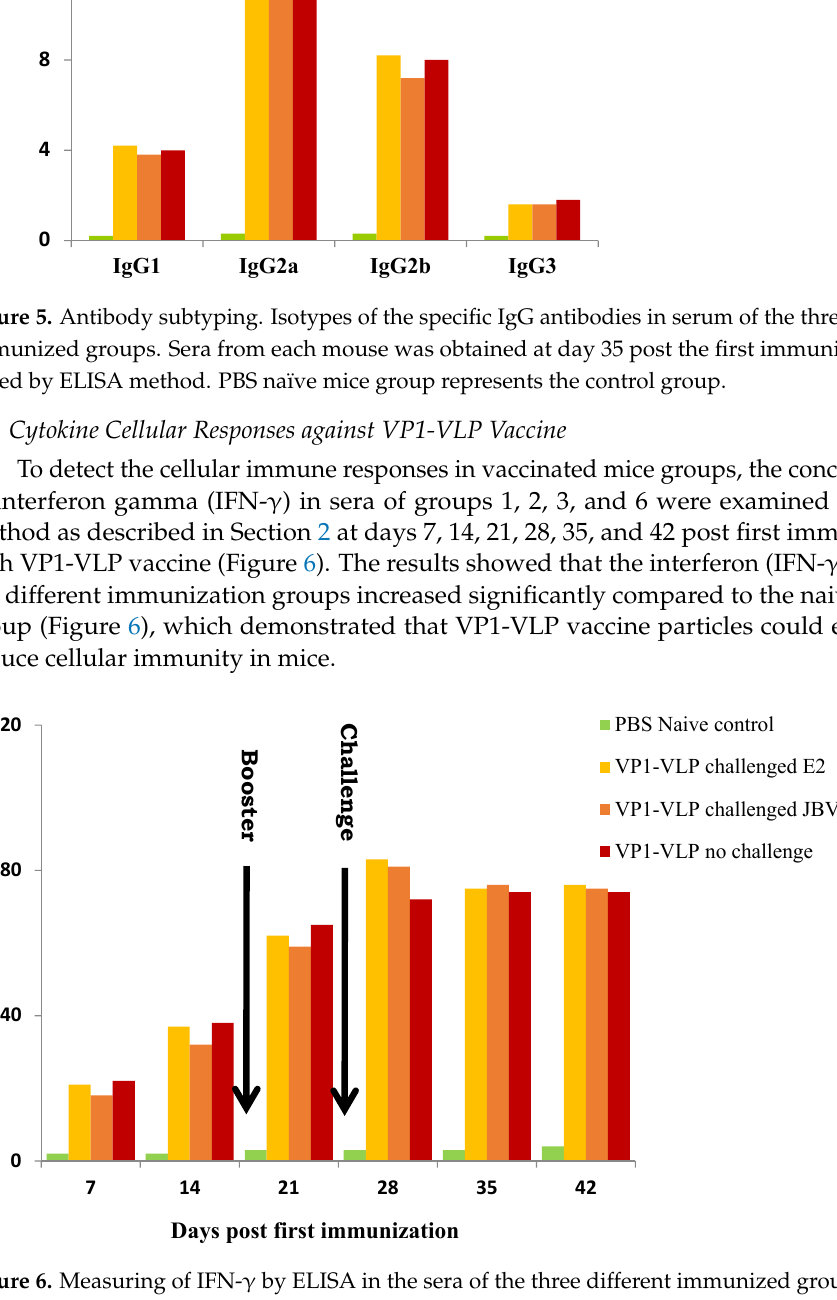
Figure 4. Antibody response. Serum IgG recognizing VP1-VLP in immunized mice. Titers of total IgG in the three immunized groups of mice. Mice ( n = 5) receiving CVB4E2 VP1-VLP vaccine were immunized intraperitoneally by prime-boost regimen at days 0 and 15 with 0.5 µg of VP1-VLP. Mice were then challenged at day 22 with CVB4E2 or CVB4JBV pathogenic strains. PBS naïve mice group represents the control group. The results represent the mean of three replicate experiments.